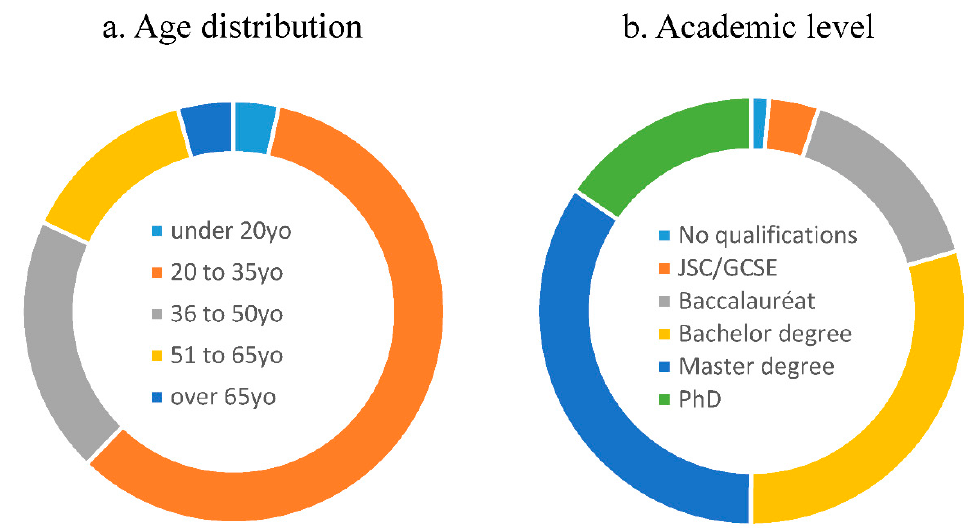
Figure 2. Age and academic levels distribution of the 2160 participants in the study. JSC is junior school certificate (GSCE or Brevet). The Baccalauréat is the equivalent of ‘A’ levels’.